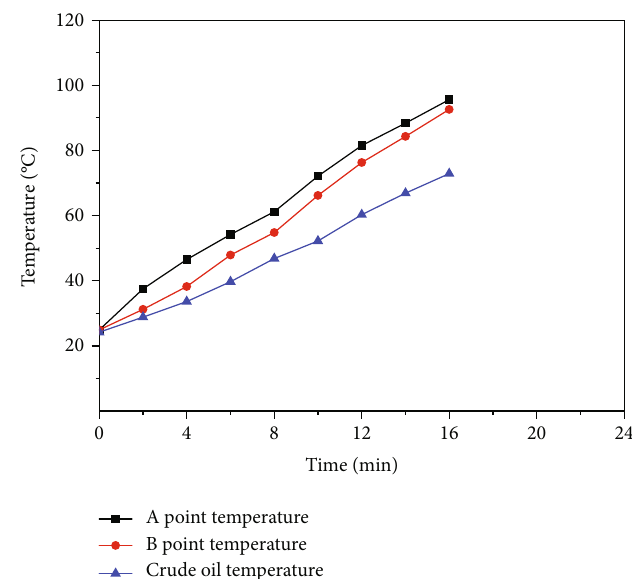
Figure 5: Temperature curve of heavy oil heated by microwave with